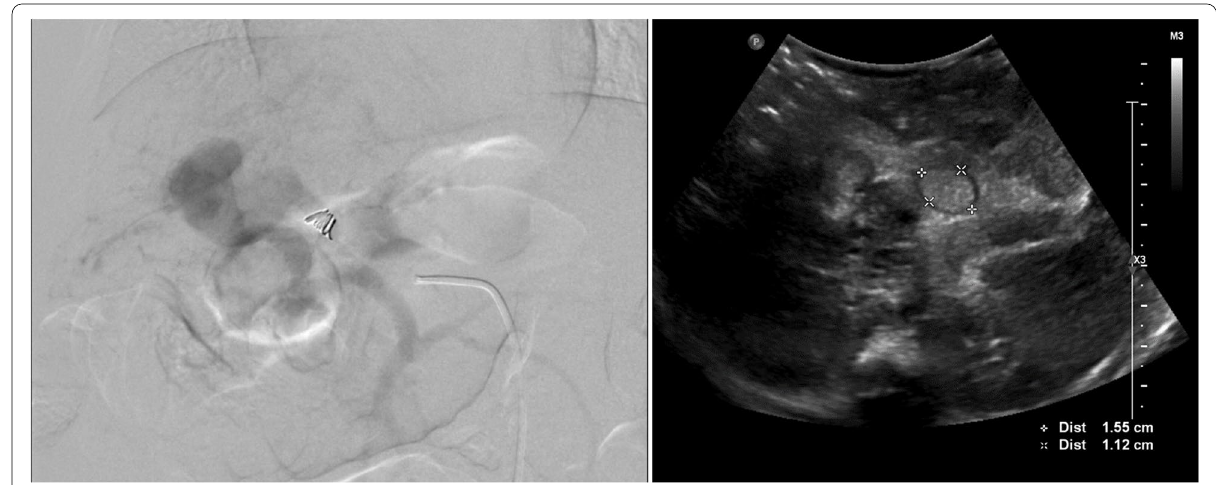
Fig. 4 Endpoint achieved with metallic coil inserted showed no flow (left) and post procedure ultrasound showed intramural thrombus